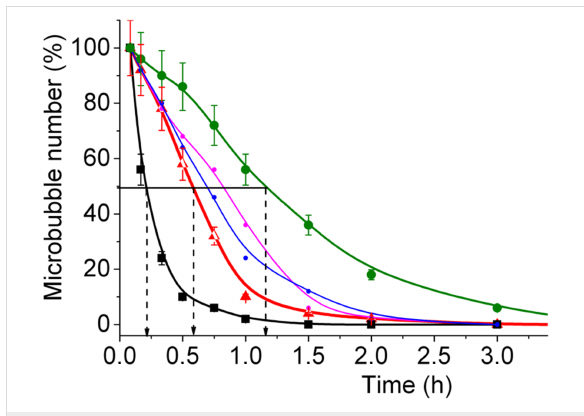
Figure 4: Half-lives of microbubbles (25 °C) containing F -lipopeptides 1 – 3 and hydrocarbon analog 4 .